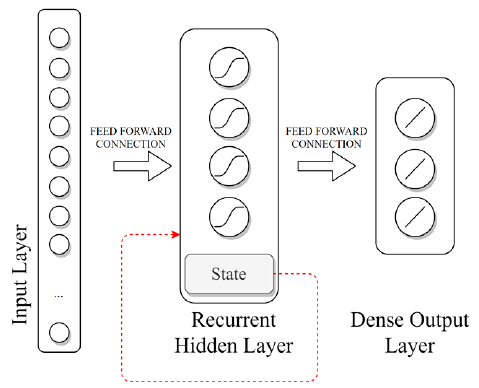
Figure 5. Layer diagram for a layer-recurrent neural network with a single hidden recurrent layer with neurons featuring non-linear activation function.